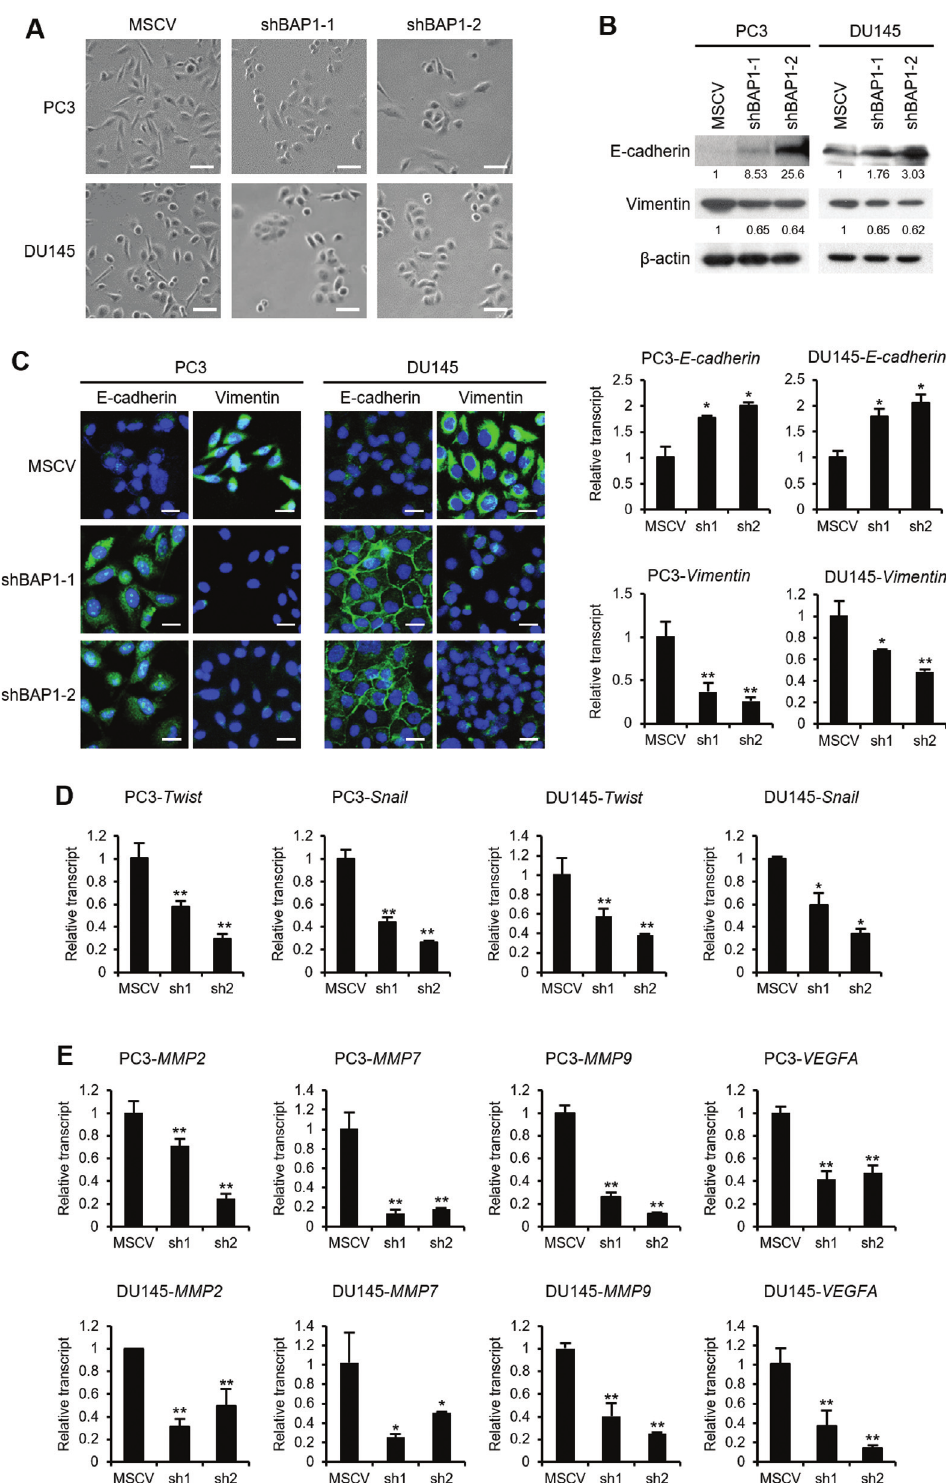
Figure 2 - BAP1-knockdown induces MET in prostate cancer cells. (A) Images of PC3 or DU145 cells with BAP1-knockdown (100 magnification). Scale bar represents 100 (cid:2) m. (B) Immunoblotting and real-time RT-PCR for E-cadherin and vimentin in BAP1-knockdown cell lines. The band density was quantified by densitometry. (C) Immunofluorescence for E-cadherin or vimentin (green) in BAP1-knockdown cells. Nuclear DNA was stained with DAPI and the image was merged with that of E-cadherin or vimentin. Scar bar represents 20 (cid:2) m. (D) Real-time quantitative RT-PCR for Twist and Snail mRNAs in BAP1-knockdown cells. Values are expressed as mean (cid:7) SD of three independent experiments. (E) Real-time quantitative RT-PCR for MMP2 , MMP7 , MMP9 , and VEGFA mRNAs in BAP1-knockdown cells. Values are expressed as mean (cid:7) SD of three independent experiments. The p values were calculated using Student’s t -test. * p < 0.05, ** p <